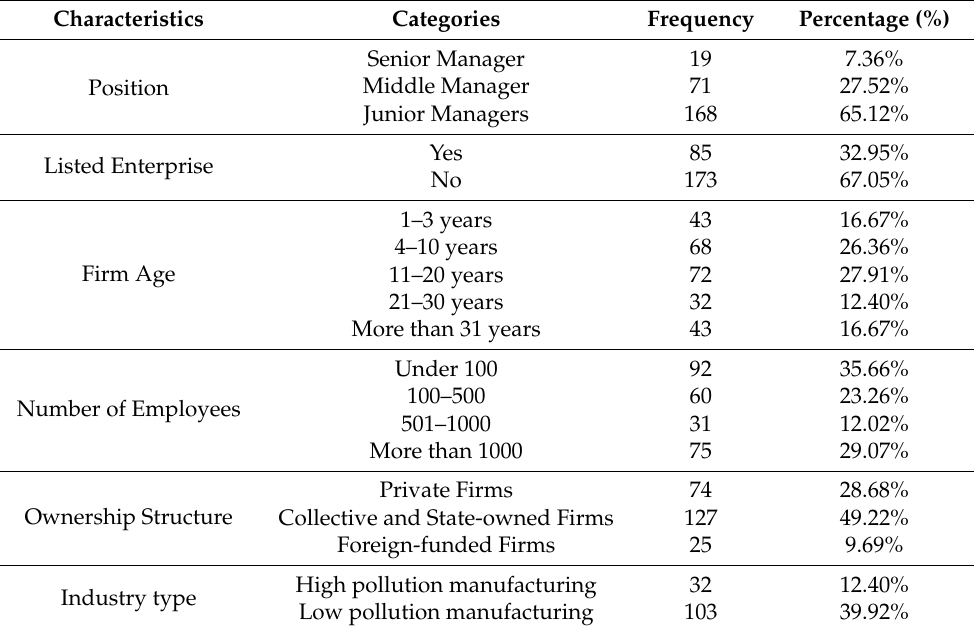
Table 1. Characteristics of the